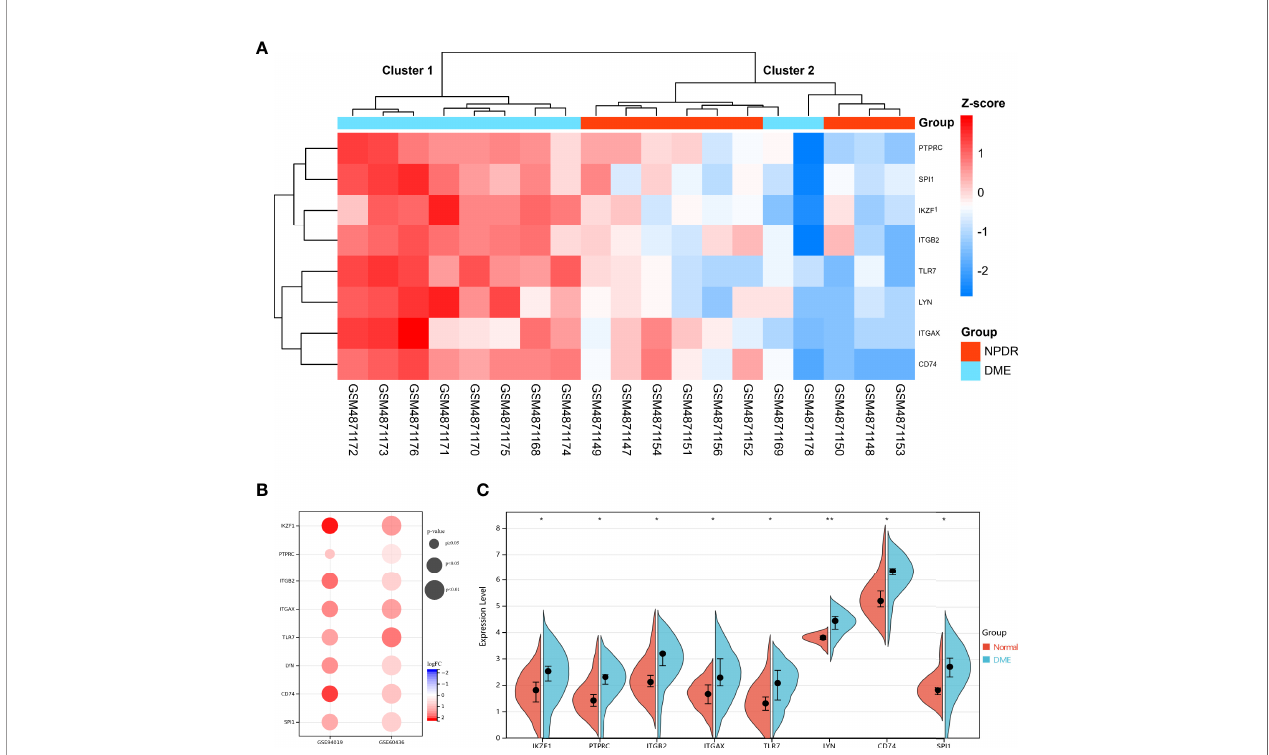
FIGURE 5 | Expression pattern of DECD8+TRGs in DR. (A) Unsupervised hierarchical clustering heat map of eight Hub DECD8+TRGs in GSE160306, which illustrates the difference of z-score between NPDR and DME. (B) DECD8+TRGs were validated between normal retina and PDR fi brovascular membrane in different independent datasets. (C) The difference between normal and DME of eight Hub DECD8+TRGs in GSE160306. *p < 0.05, **p <